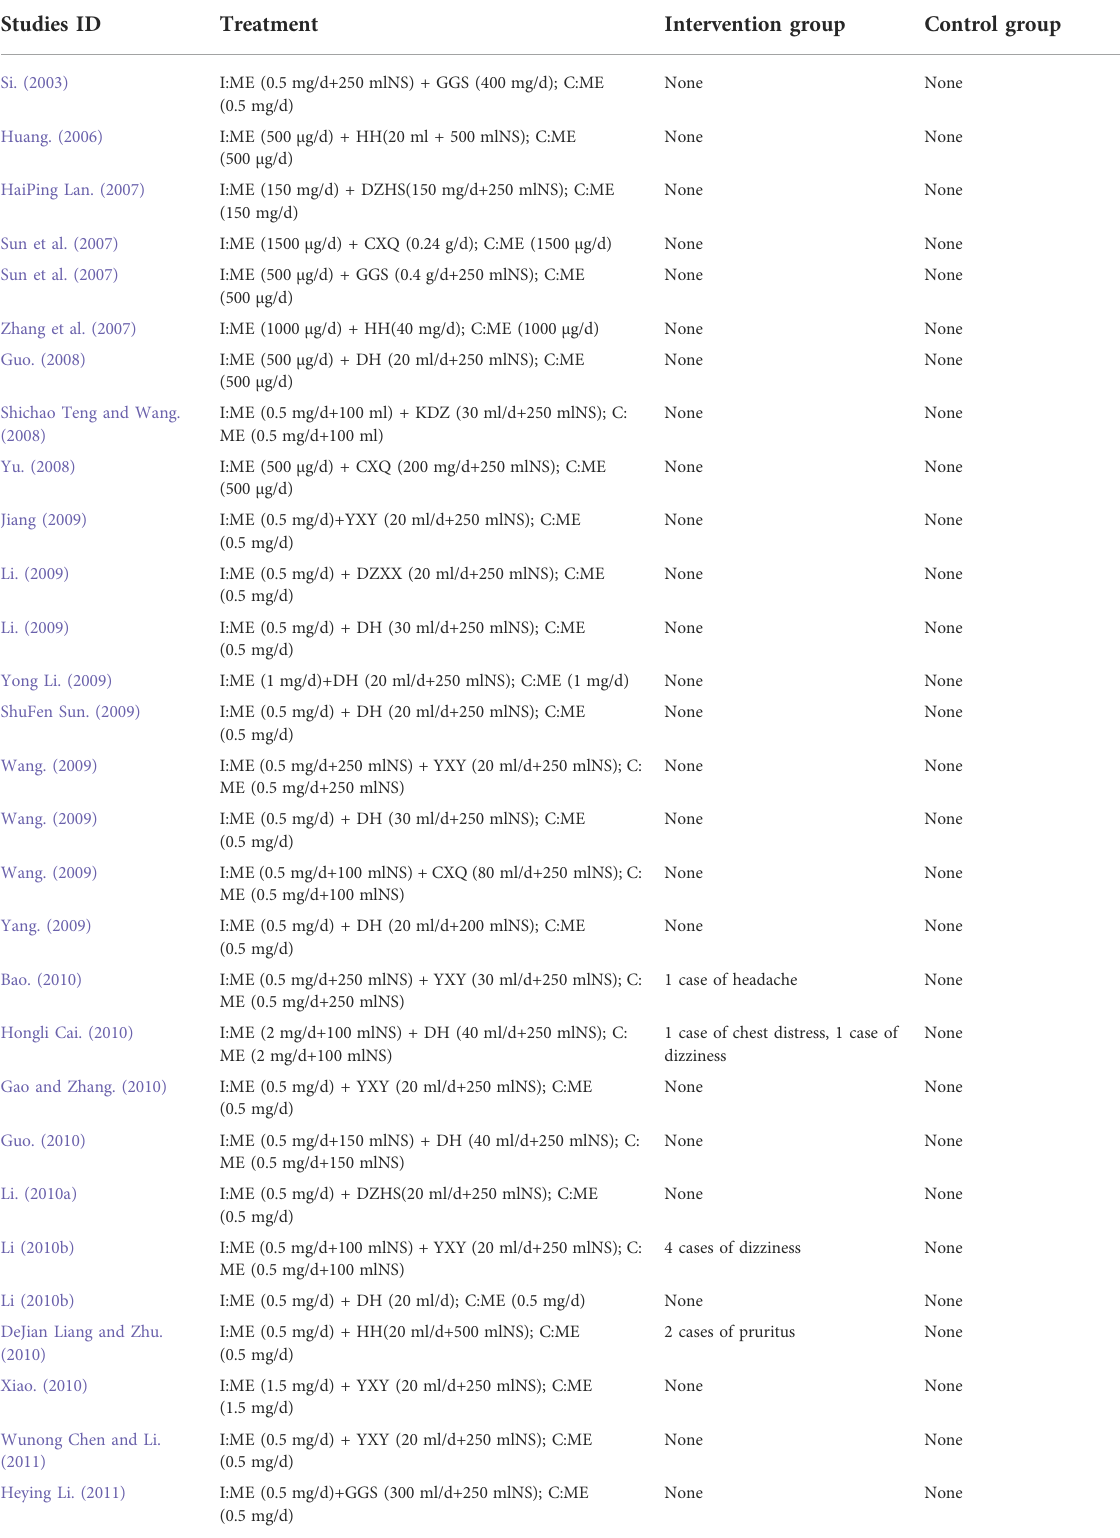
TABLE 8 Details of the adverse event occurred in the included